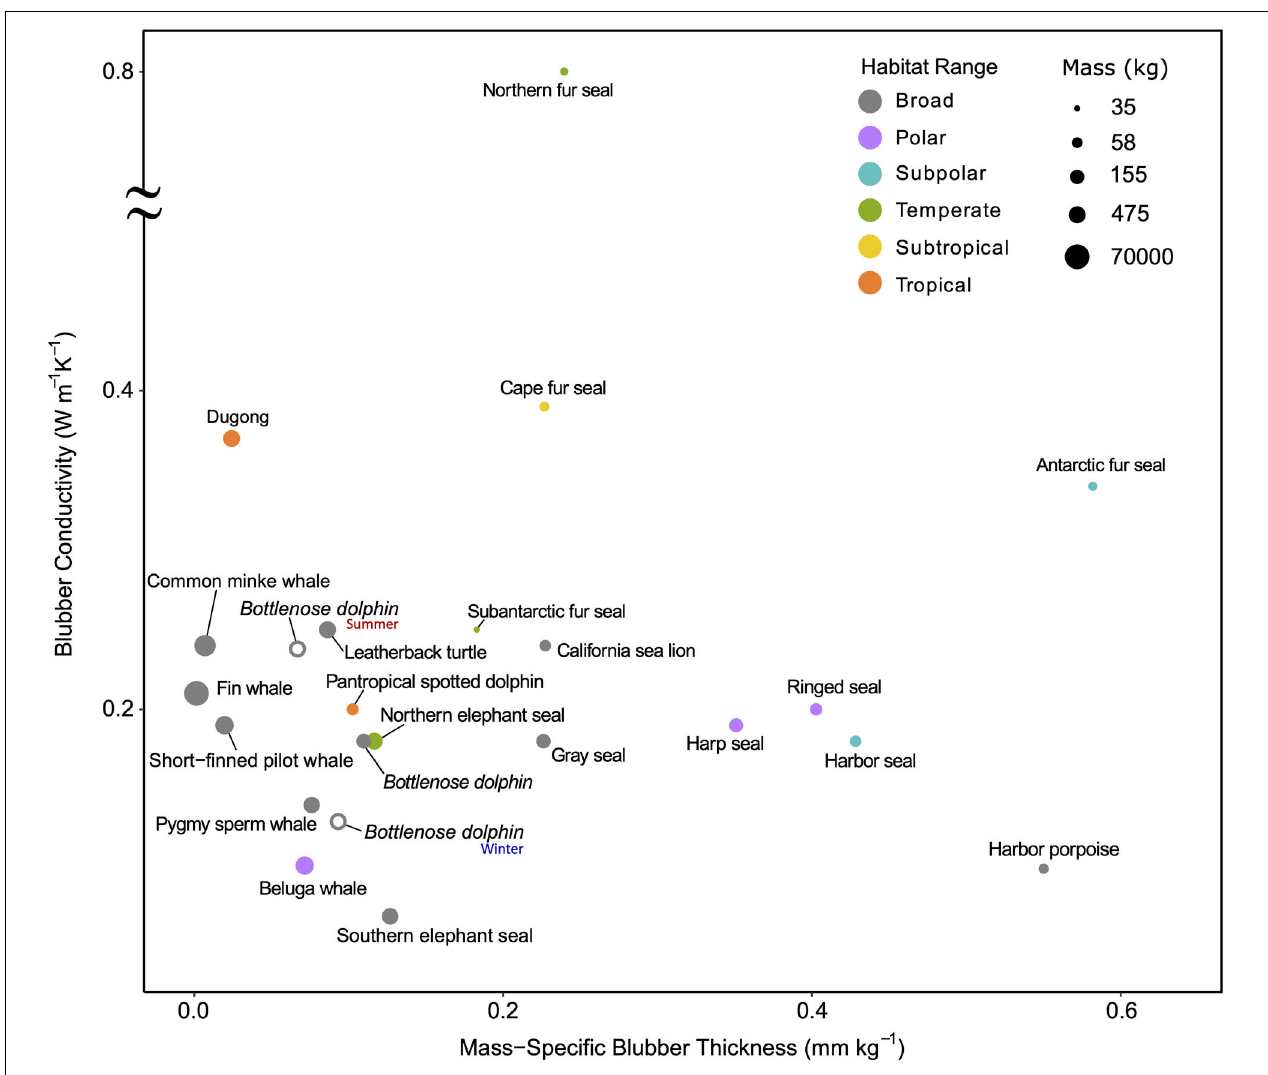
FIGURE 6 | Ex vivo blubber conductivity vs. mass-specific blubber thickness demonstrates the variability between species occupying different thermal habitat ranges in balancing the trade-offs between quality and quantity of blubber. Blubber quality here is represented by conductivity, where lower values mean less heat transfer and thus better-quality insulation. Larger whales and broadly distributed species have relatively little, but high-quality blubber. The poor-quality blubber of the Northern fur seal is compensated by its thick fur; in contrast, dugongs have poor insulation and thus a narrow thermal niche. Blubber conductivity was determined using the method indicated in Supplementary Table S3 on excised samples. The only exceptions are the two additional bottlenose dolphins plotted as open points that use data from live animals in winter and summer months to demonstrate the seasonal effects of temperature on insulation. Refer to Supplementary Table S1 for absolute latitudes used for determining habitat range (broad indicates the species span more than one habitat range) and Supplementary Table S3 for blubber and mass data